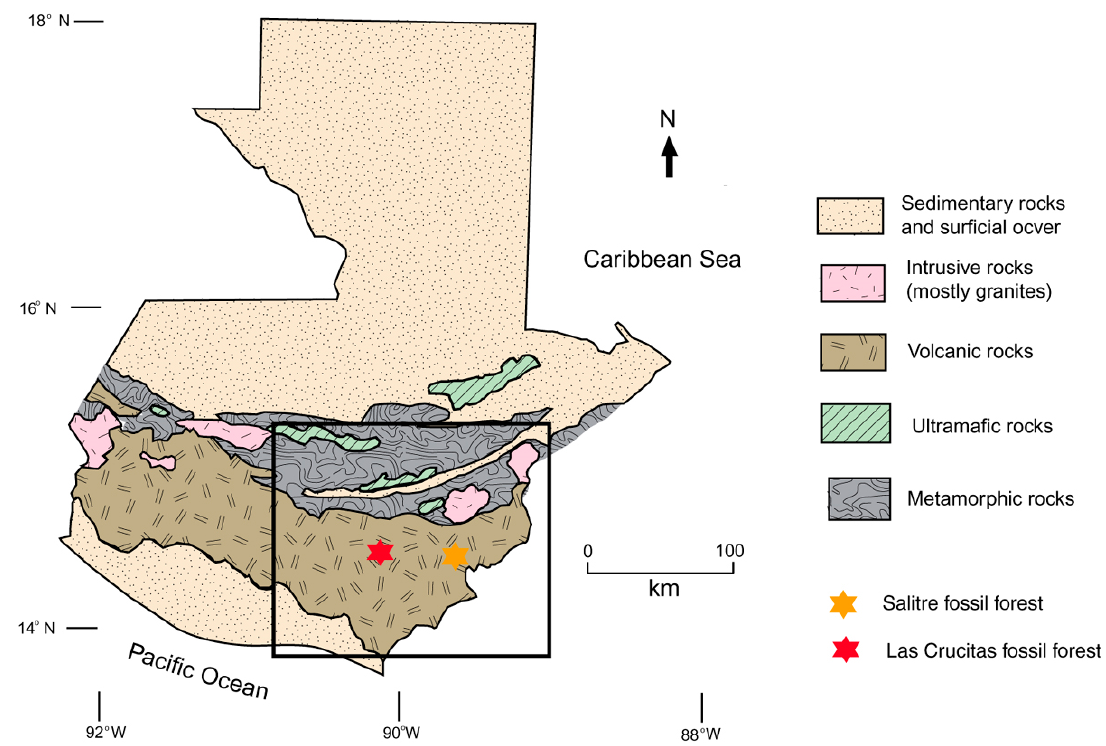
Figure 6. Geologic map of southeast Guatemala. Modified from [9].